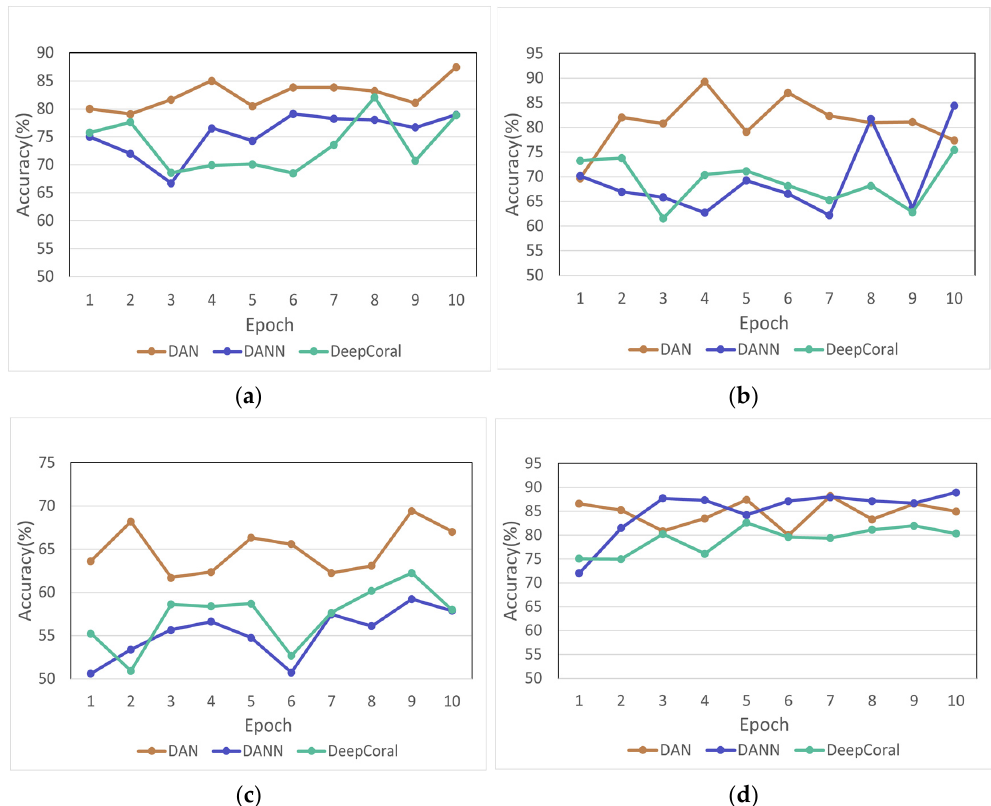
Figure 7. Prediction accuracy of three-map plotting and RGB synthesis under different sample ra- tios. (Assuming that each group contains a healthy sample and a depression sample, 4:4 means that four groups are the training set and the other four groups are the test set; 7:1 means that the seven groups are the training set and the other one group is the test set. Additionally, the healthy and depressed samples in all groups were from different participants).